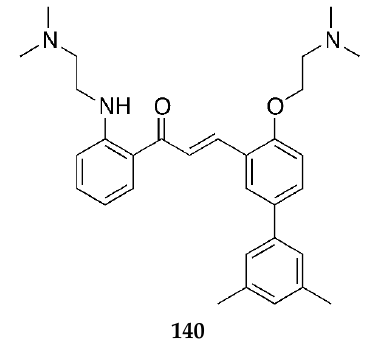
Figure 53. Chemical structure of the mono alkylated 2-aminochalcones derivative.